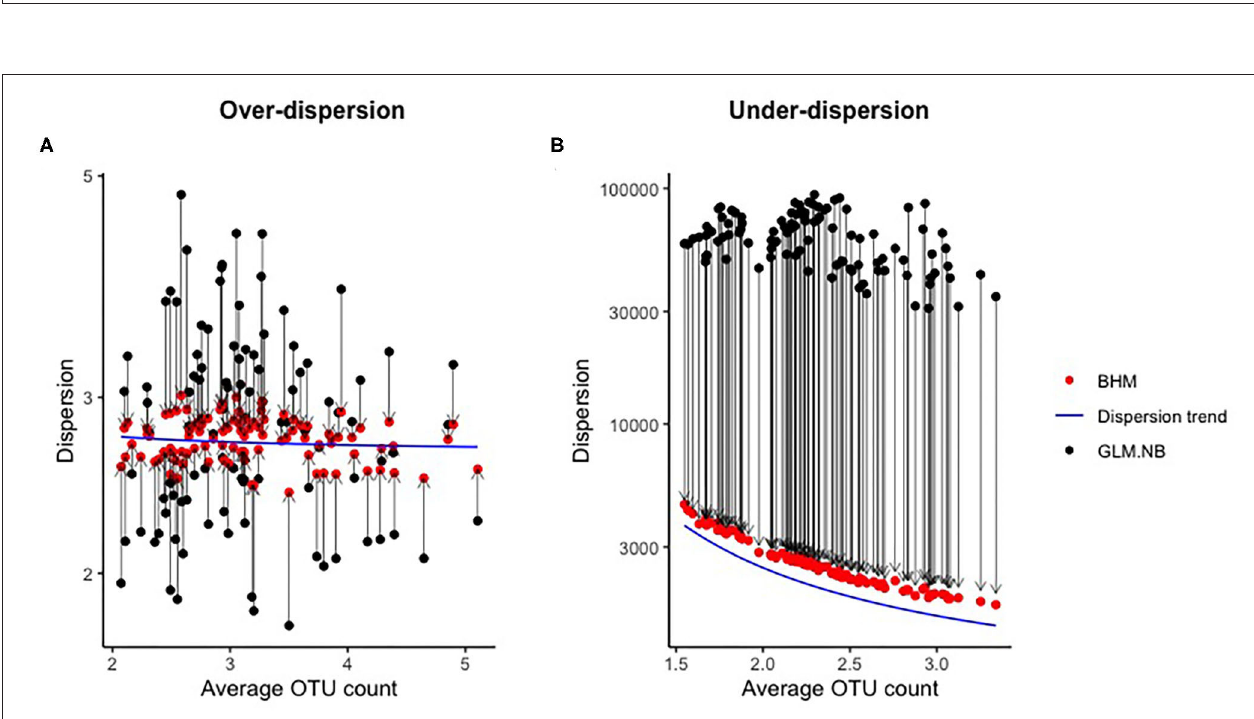
FIGURE 2 | Effect of regularization of the dispersion parameter in the simulation study. Every black-red bot represents a combination of the estimated dispersion parameter of the GLM.NB method (black) and the posterior mean of the BHM (red) method for a single OTU. The blue line is the dispersion trend as estimated by the BHM